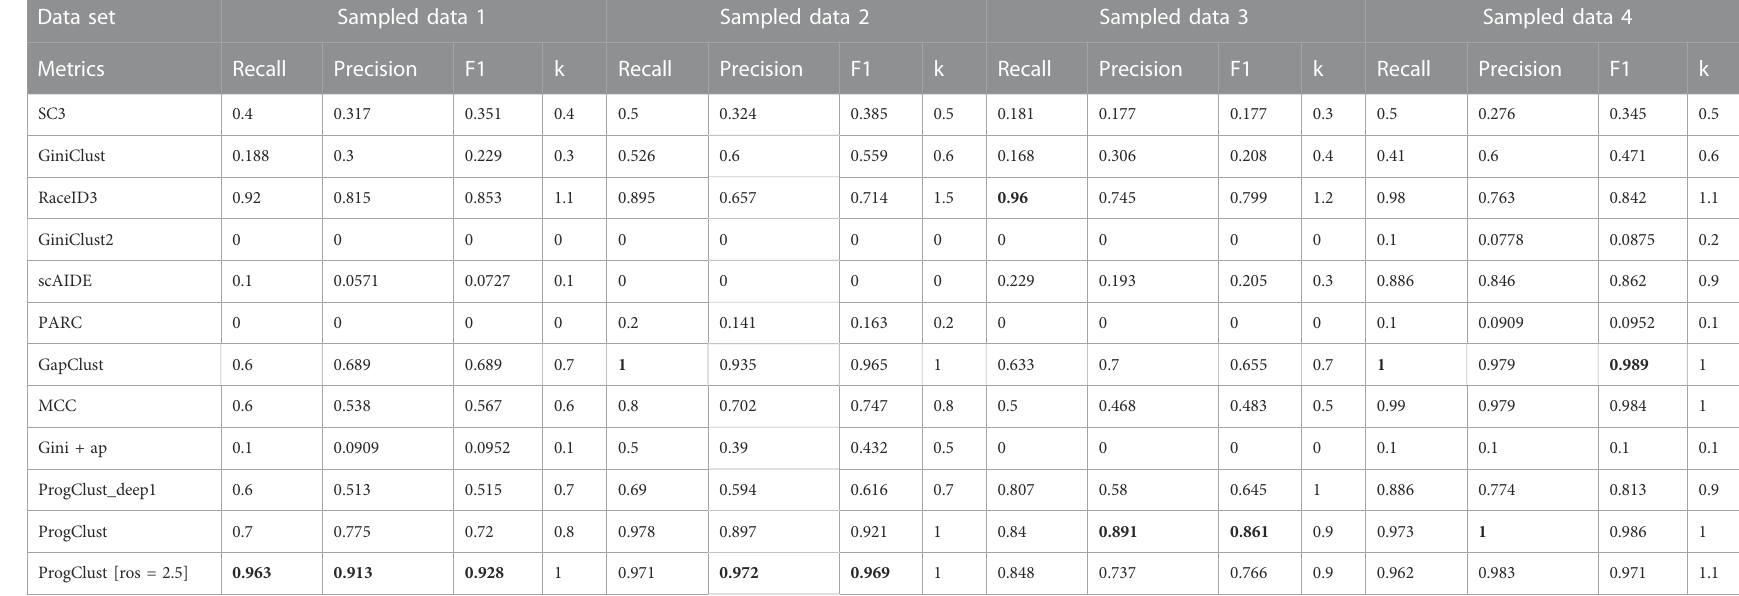
ProgClust [ros = 2.5] Bold values represent the values with the highest performance metrics on the current